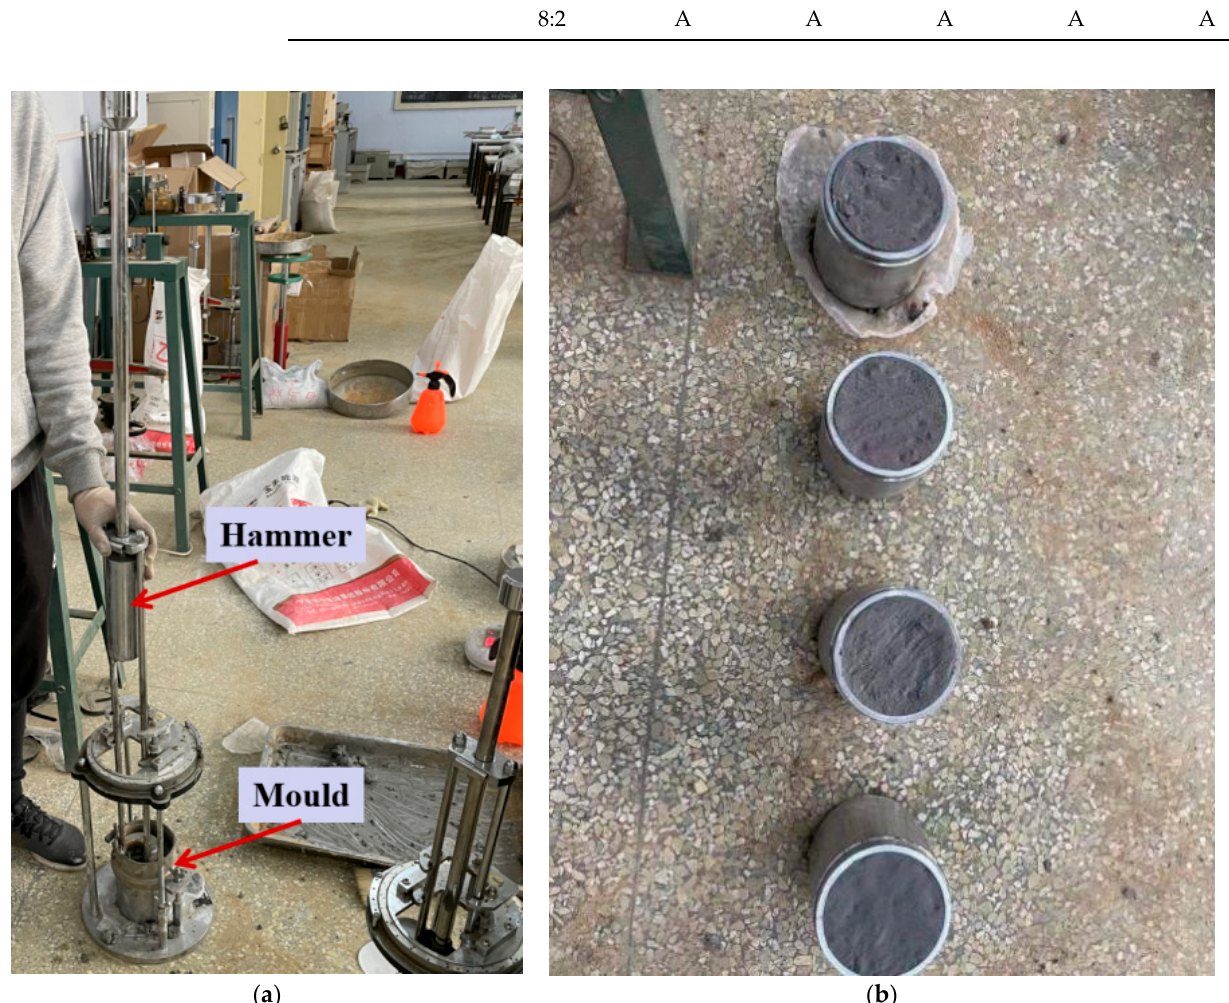
Figure 2. Compaction experiment: ( a ) compaction test equipment; ( b ) compaction test sample preparation.